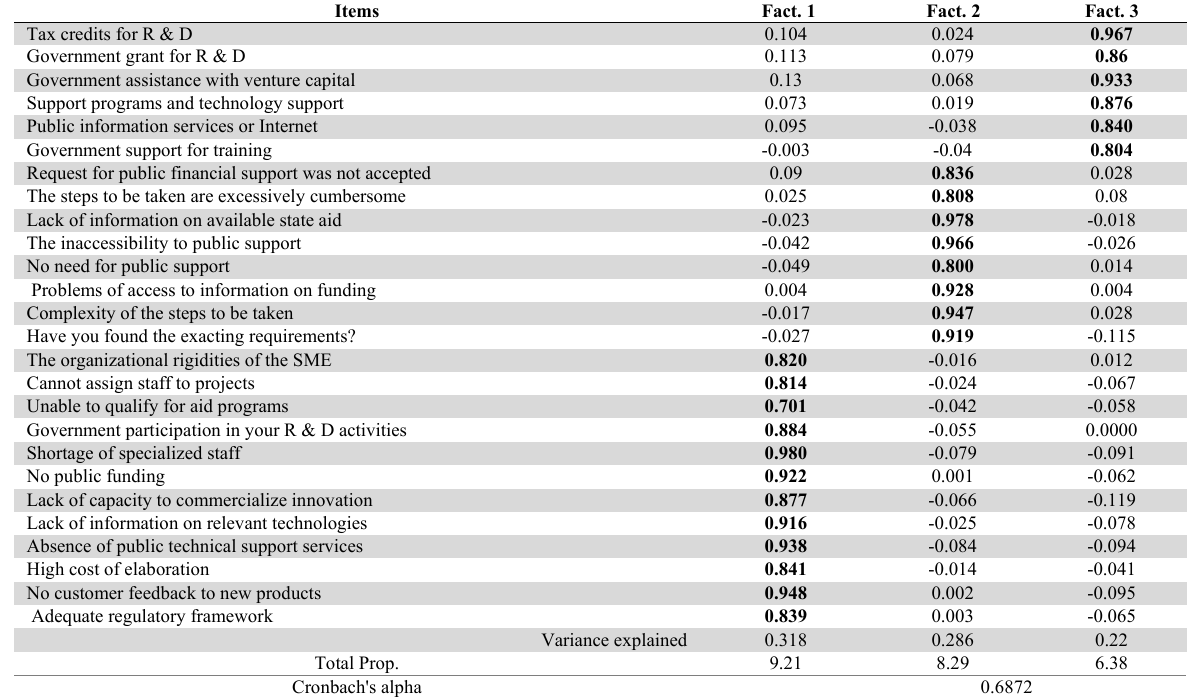
Principal component analysis of the variable relating to public support for innovation: Factor Weights (Varimax Standard- ized) Items Fact. 1